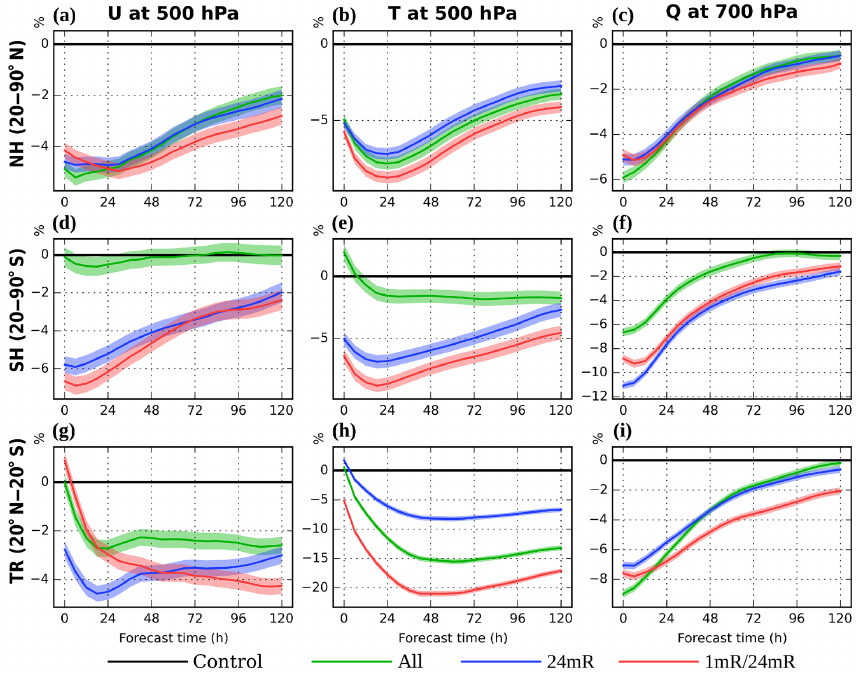
Figure 7. Same as Fig. 6, but for RMSE relative to CONTROL (percent) in different verification regions: (a–c) Northern Hemisphere extratropics (NH; 20–90 ◦ N), (d–f) Southern Hemisphere extratropics (SH; 20–90 ◦ S), and (g–i) tropics (TR; 20 ◦ N–20 ◦